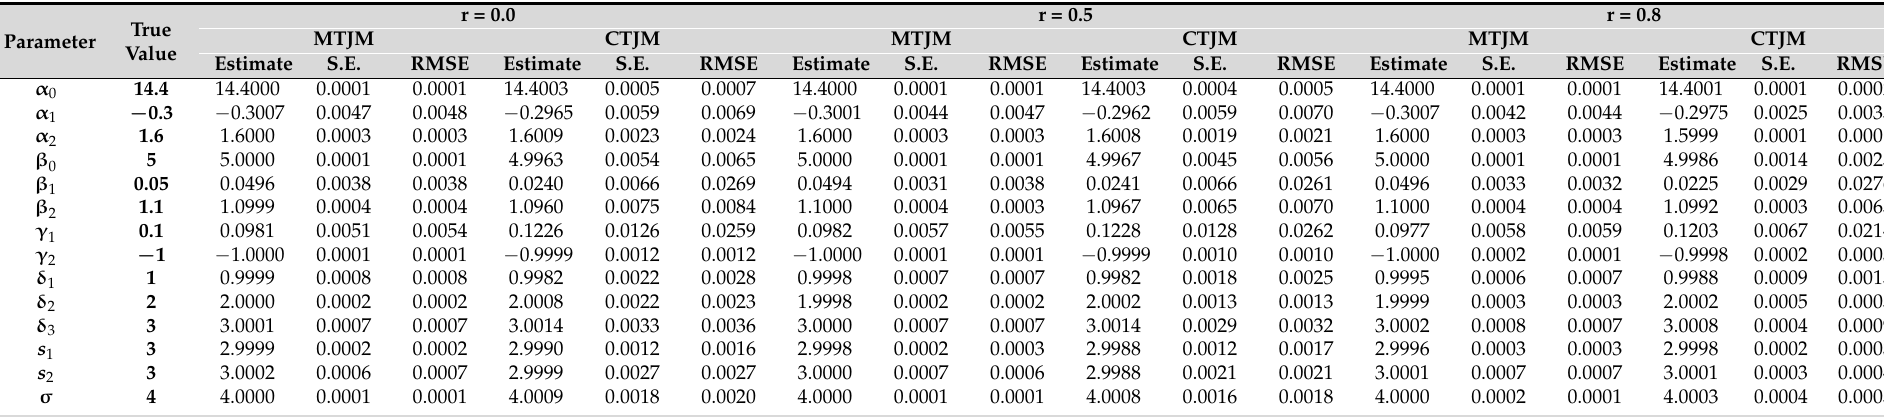
Table 1. Simulation study: marginalized two-part joint model (MTJM) and conventional two-part joint model (CTJM) under n = 250.